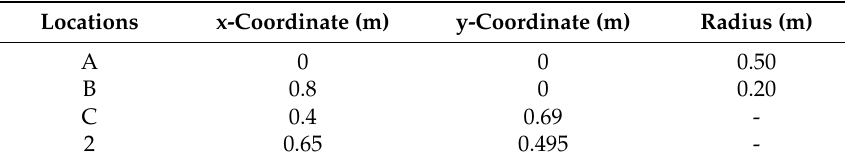
Table 4. Initial data of the second case study.